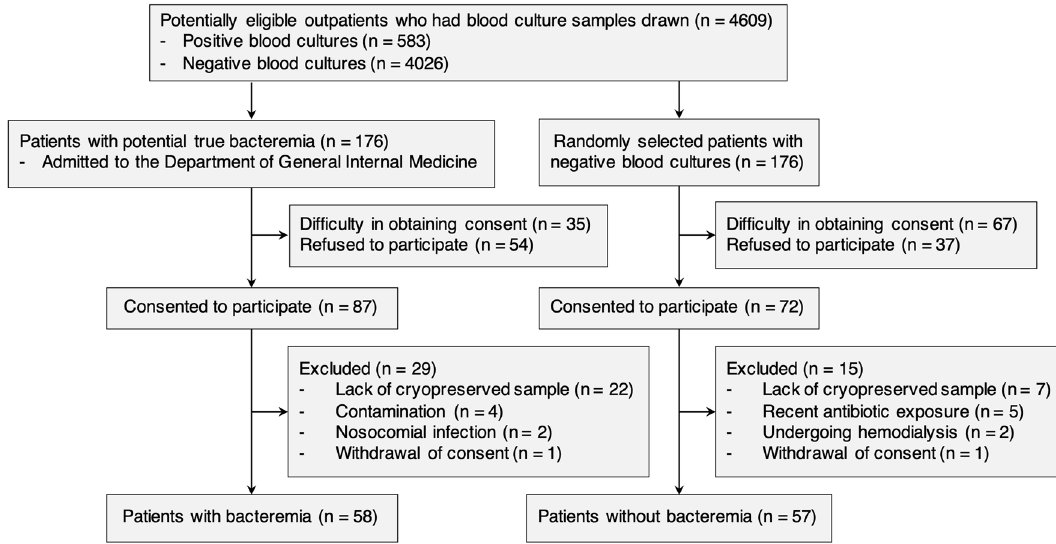
Figure 1. Flow diagram showing the selection criteria for patients with or without bacteremia. The reasons for difficulty in obtaining consent from patients with bacteremia included disorders of consciousness or disorientation (n = 28) and lack of written consent (n = 7). The reasons for difficulty in obtaining consent from patients without bacteremia included lack of written consent (n = 45), loss of contact (n = 16), and disorders of consciousness or disorientation (n =